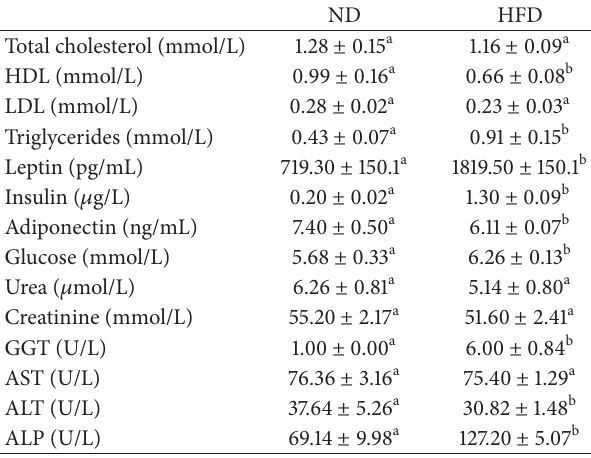
Table 1: The plasma biochemistry of rats fed a normal diet (ND) or a high fat diet (HFD) for 12 weeks to induce